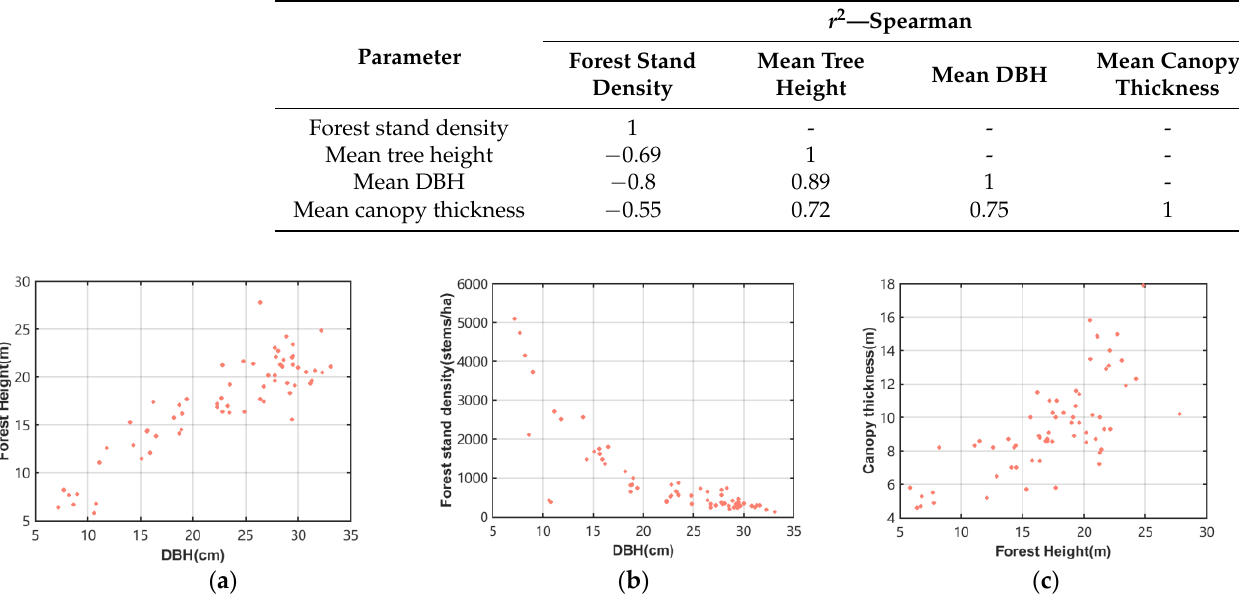
Figure 2. Relationship between the forest structure parameters at the plot level. ( a ) Mean DBH vs. mean tree height, ( b ) mean DBH vs. forest stand density and ( c ) mean tree height vs. mean canopy thickness.